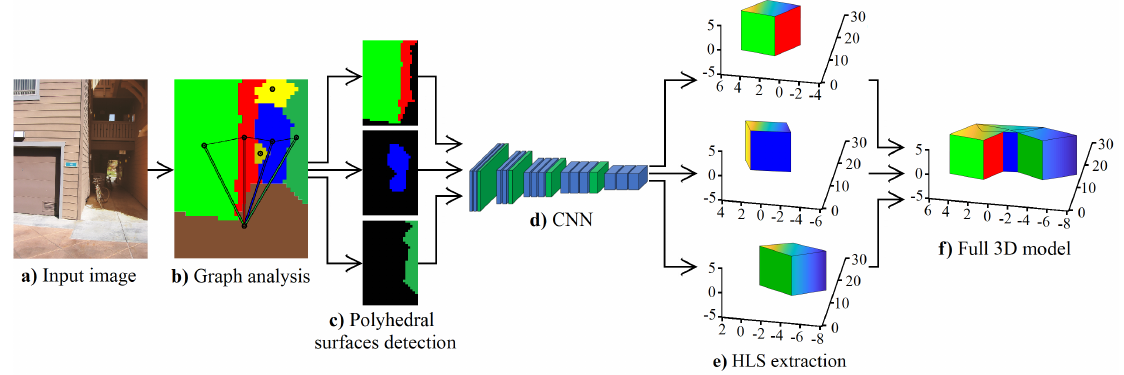
Figure 1. Block diagram of the proposed method. HLS, High-Level